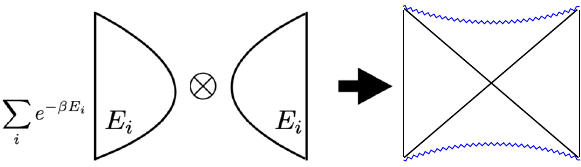
Fig. 1 Following, Ref. [133], the figure depicts that the entanglement product of two disconnected CFT corresponds to a connected geometry, Penrose diagram of which is shown in the right, explained later in Fig.